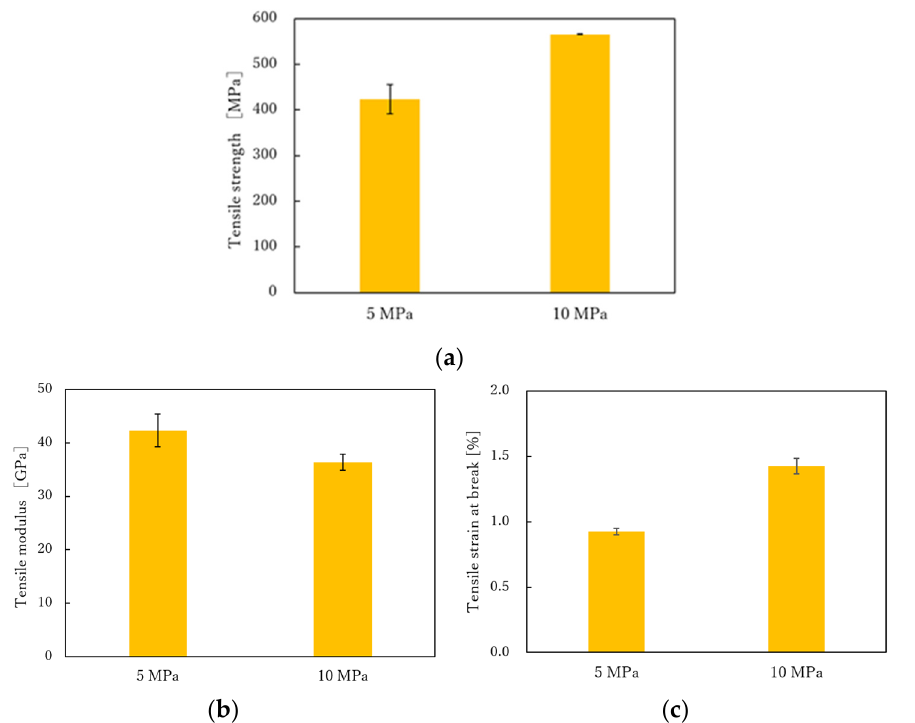
Figure 9. ( a ) Effect of molding pressure on tensile strength under molding time of 30 min; ( b ) Effect of molding pressure on tensile modulus under molding time of 30 min and ( c ) Effect of molding pressure on tensile strain at break under molding time of 30 min.